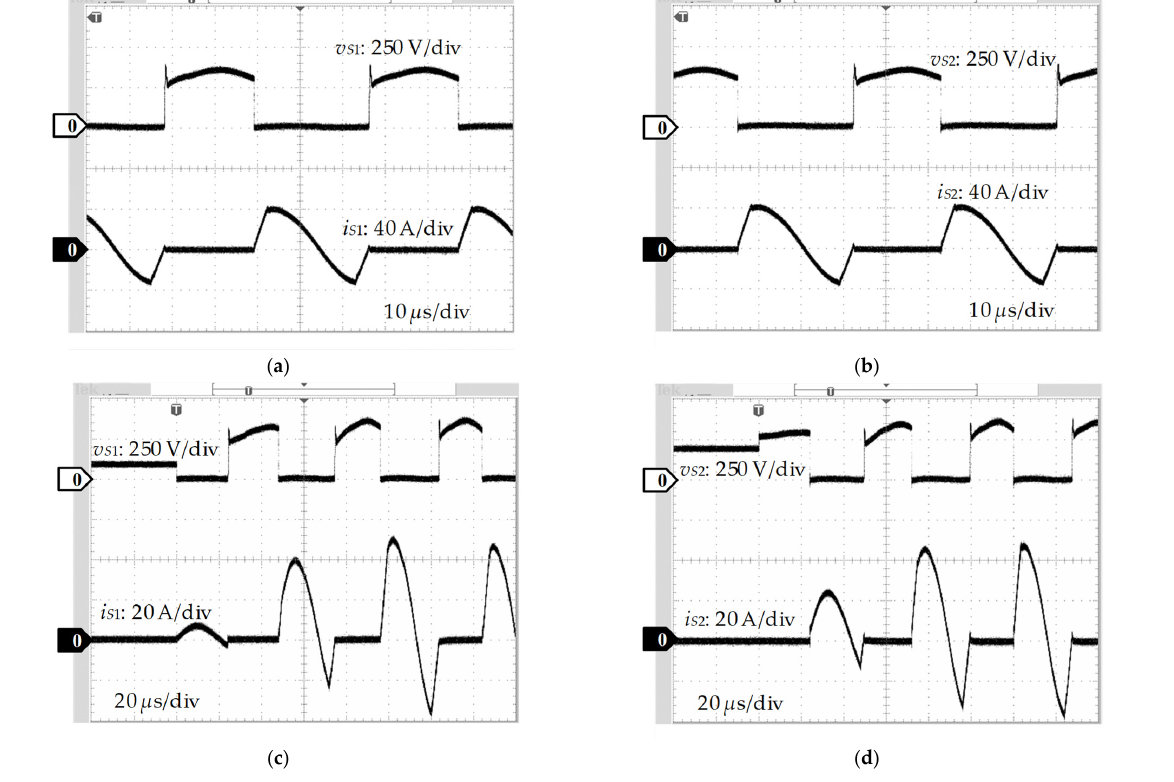
Figure 8. Current and voltage waveforms for switches S 1 and S 2 . ( a ) Steady-state condition for switch S 1 . ( b ) Steady-state condition for switch S 2 . ( c ) Beginning of power injection for switch S 1 . ( d ) Beginning of power injection for switch S 2 .